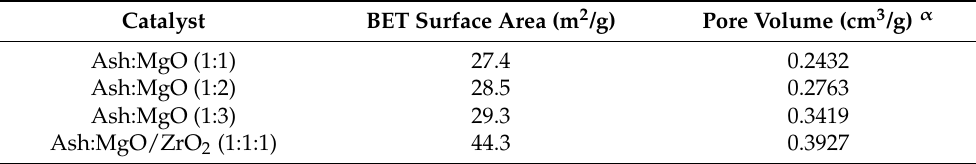
Table 2. Catalyst size analyzed according to BET surface area and pore volume.